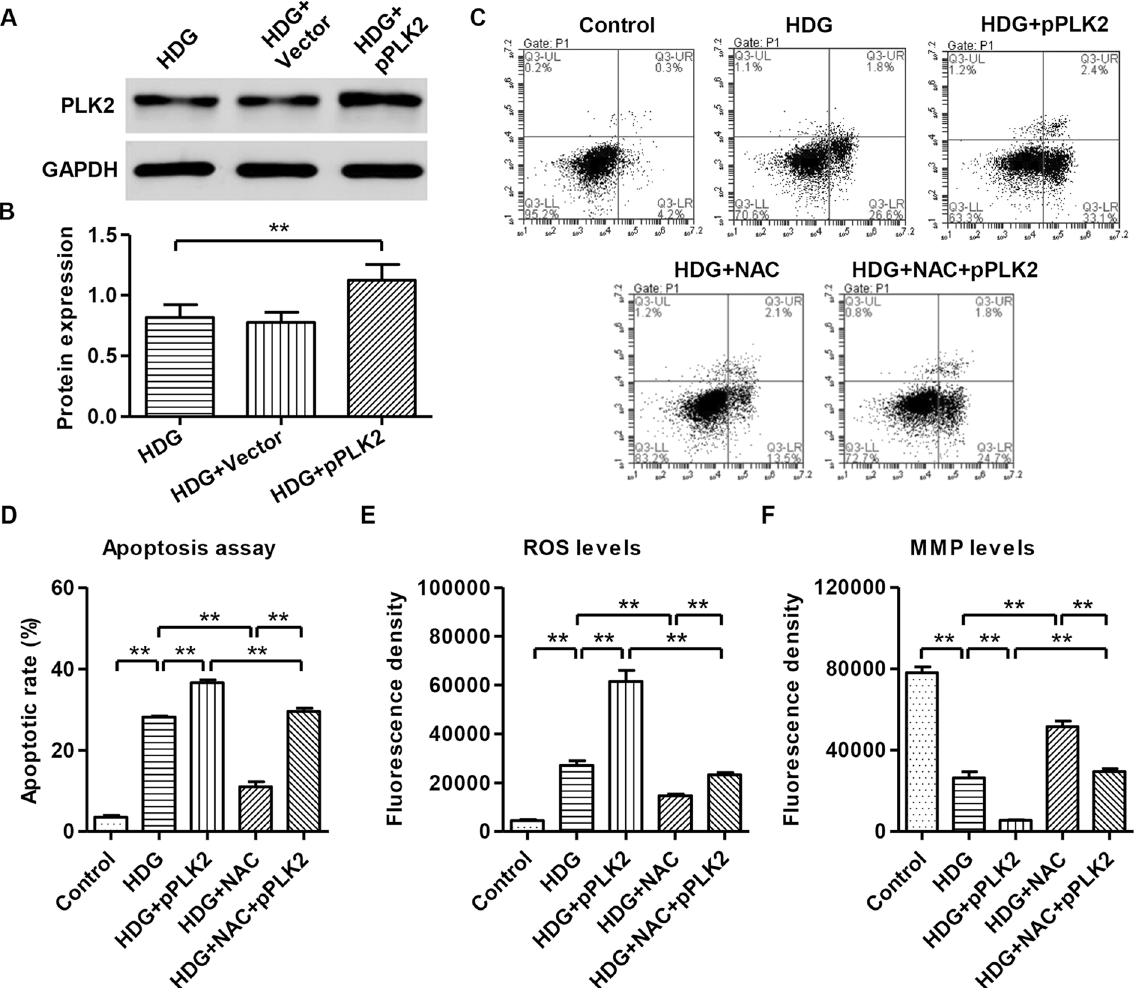
Figure 6. NAC blocked PLK2 overexpression effects on apoptosis, ROS generation, and MMP production. Mouse podocytes were treated with 30 mM HDG prior to 100 μ M NAC treatment. ( A,B ) Overexpression of PLK2 at 24 h in the presence of HDG. ( C,D ) Cell apoptosis was measured by annexin V-fluorescein isothiocyanate (FITC) and PI, prior to analysis by a flow cytometry 12 h after HDG treatment. ( E ) ROS generation was measured by DCFH-DA fluorescent probe inflow cytometry1 h after HDG treatment. ( F ) MMP level was measured by JC-1 inflow cytometry1 h after HDG treatment. Overexpressing PLK2 exaggerated HDG effects. NAC attenuated HDG and PLK2 overexpressing effects. ** P <